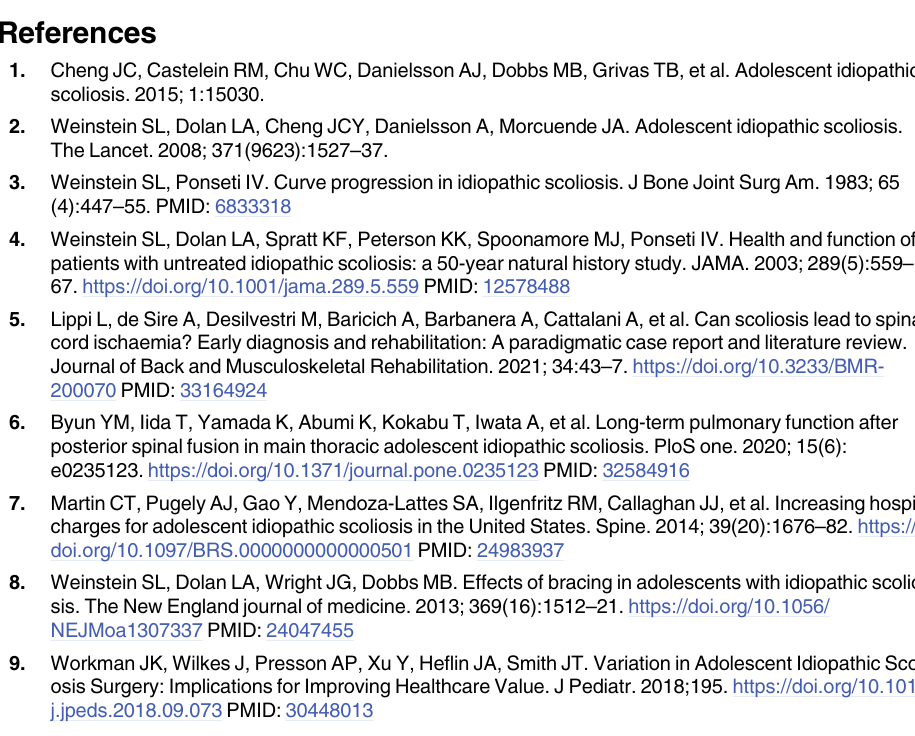
S2 Table. Full search strategies. S3 Table. List of excluded studies and reasons for exclusion. S4 Table. Overall GRADE quality assessment for the primary outcome (bracing compli-